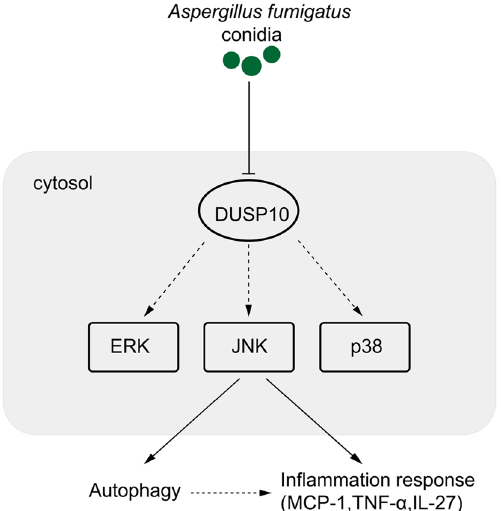
Figure 6. A. fumigatus may induce the secretion of cytokines through JNK signal relating to autophagy in bronchial epithelial cells. Molecular mechanism of inflammation and autophagy induction by A. fumigatus conidia. The above process was mediated by JNK pathway and independent of p38 and